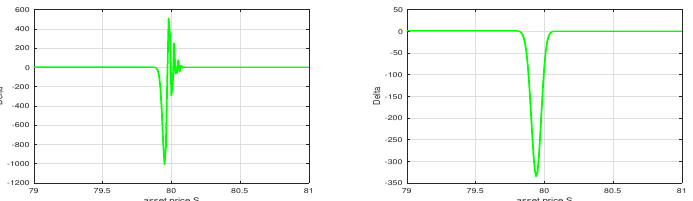
Figure 12. Plots of Delta obtained with the MADE scheme ( left ) and the MMADE scheme ( right ), with parameter values r = 0.07, σ = 0.001, a = − 8800, K = 50, T = 0.01, U = 80, L = 20, S max = 120, ∆ S = 0.01 and ∆ t = 10 − 4 .